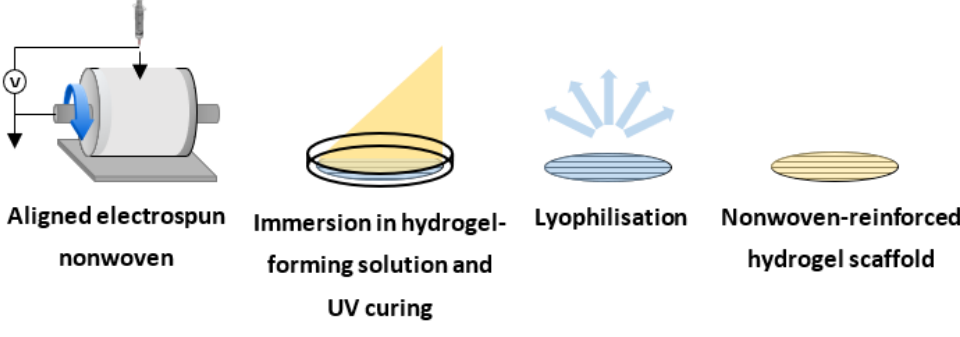
Figure 1. Diagram showing the scaffold manufacturing process. Nonwoven is electrospun on to a rotating drum to highly align fibres. The sheet of highly aligned nonwoven is then immersed in hydrogel-forming solution using silicone moulds sandwiched between glass slides and UV cured. Lastly, the scaffold is lyophilized to produce the nonwoven-reinforced hydrogel scaffold.